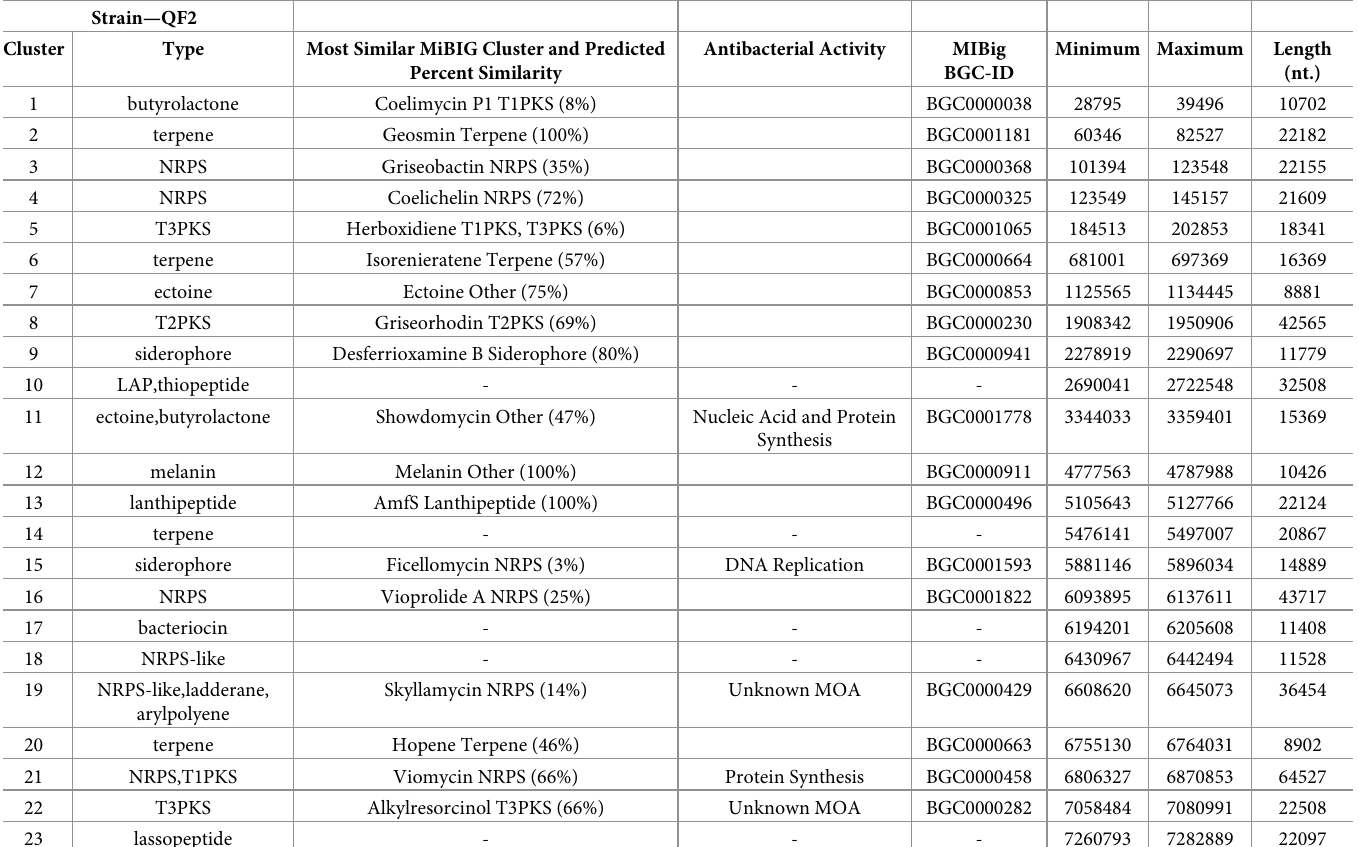
Table 2. BGCs encoded within the draft genome sequence of strain